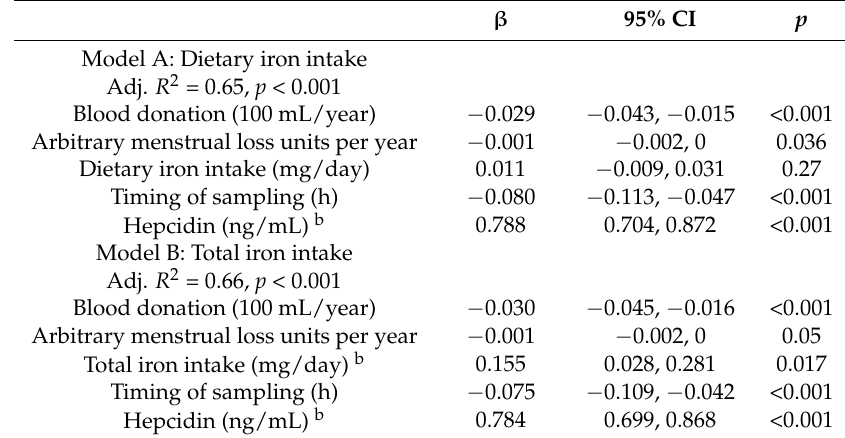
Table 4. Multivariate associations between dietary iron intake, total iron intake, hepcidin and natural log-transformed serum ferritin in women aged 18–50 years ( n = 265) a .